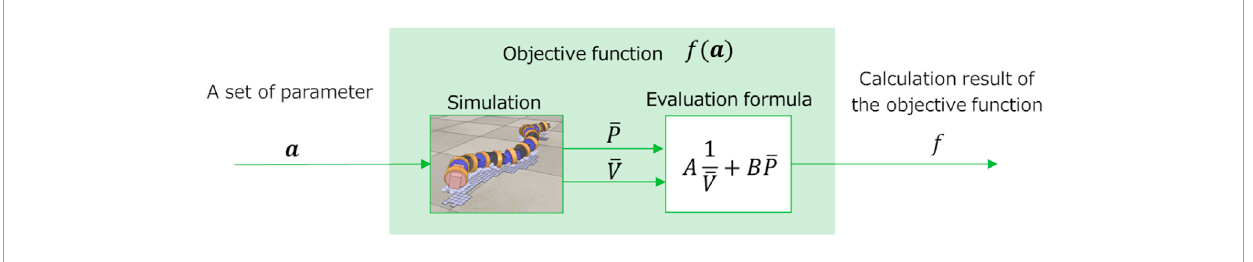
FIGURE 8 The method for calculating the objective function.